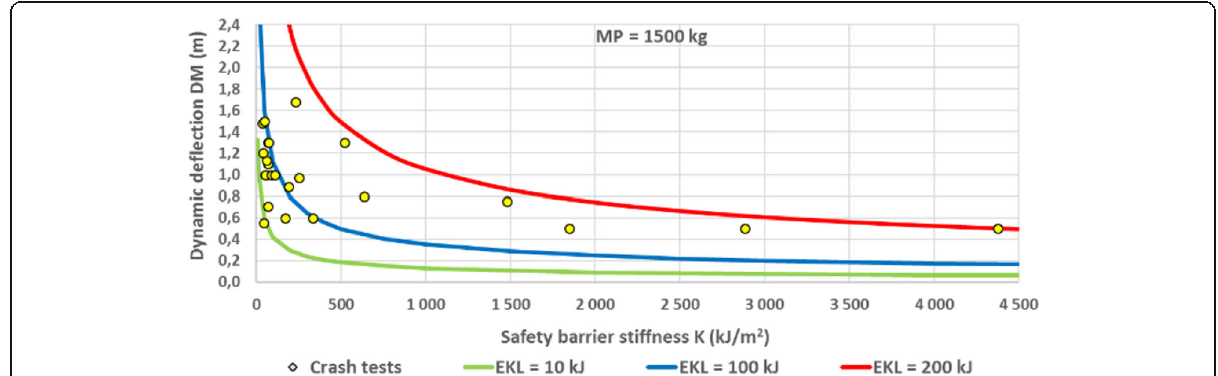
Fig. 8 Relationship between barrier dynamic deflection DM and barrier stiffness K and lateral kinetic energy of the vehicle striking the barrier EKL overlaid with the results of site tests and simulation